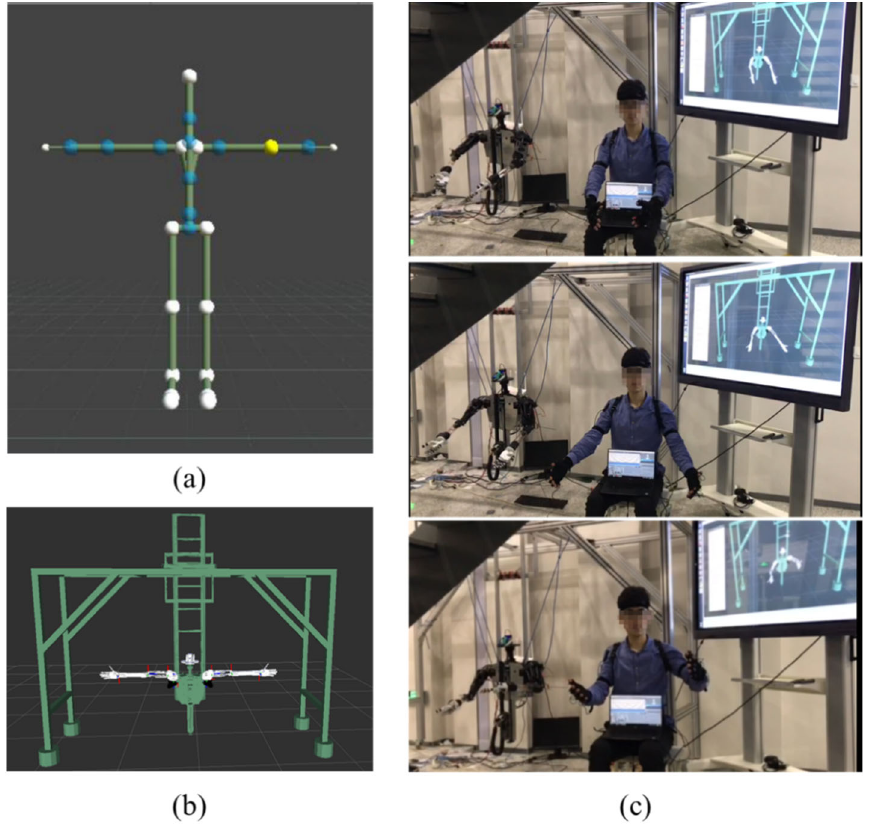
Figure 4. Motion interaction. ( a ) BVH joint diagram. ( b ) URDF visualization. ( c ) Motion interactive experiments.